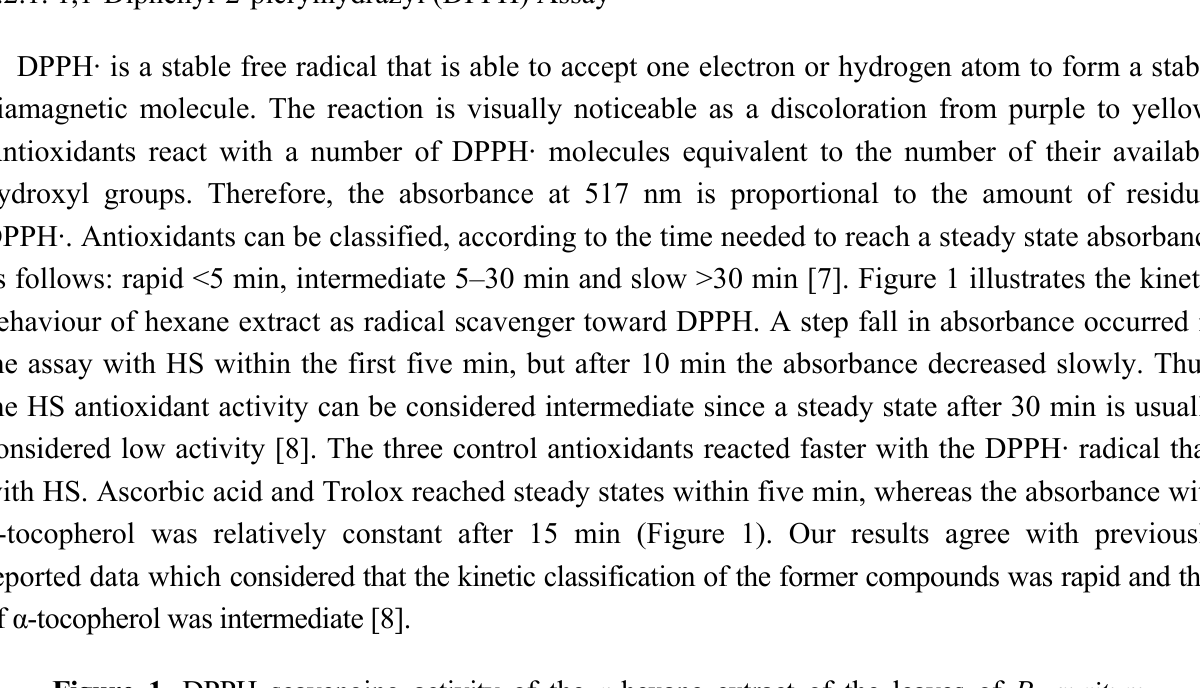
Figure 1. DPPH scavenging activity of the n -hexane extract of the leaves of P. auritum , compared to α -tocopherol, ascorbic acid and Trolox. Values are mean ± SEM and significantly p <